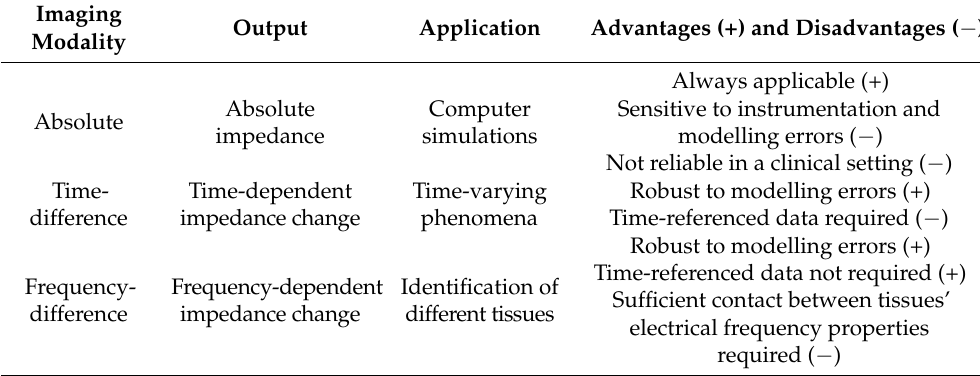
Table 1. Advantages and disadvantages of EIT imaging